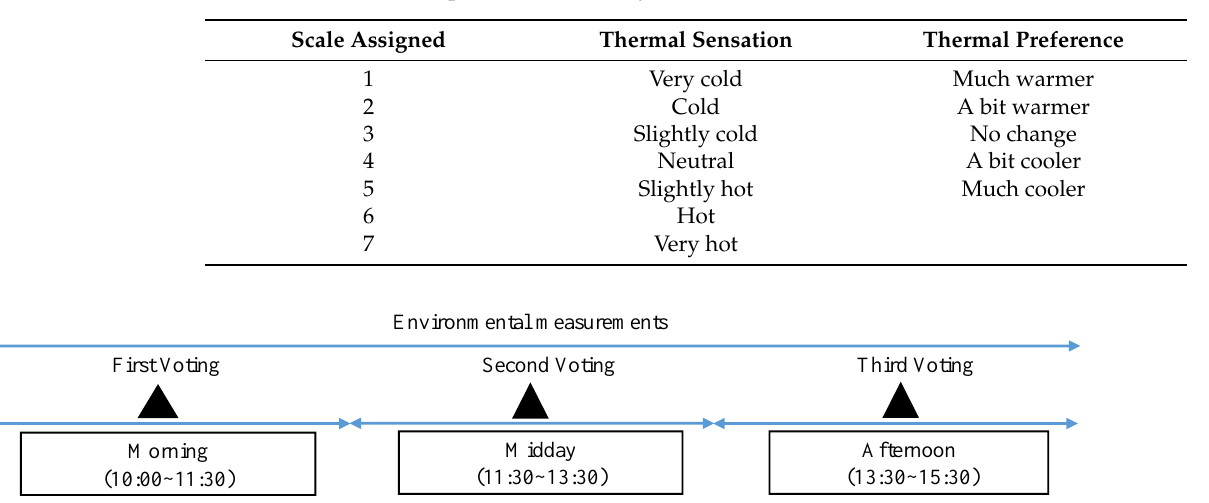
Table 4. Scales used for questionnaire survey.